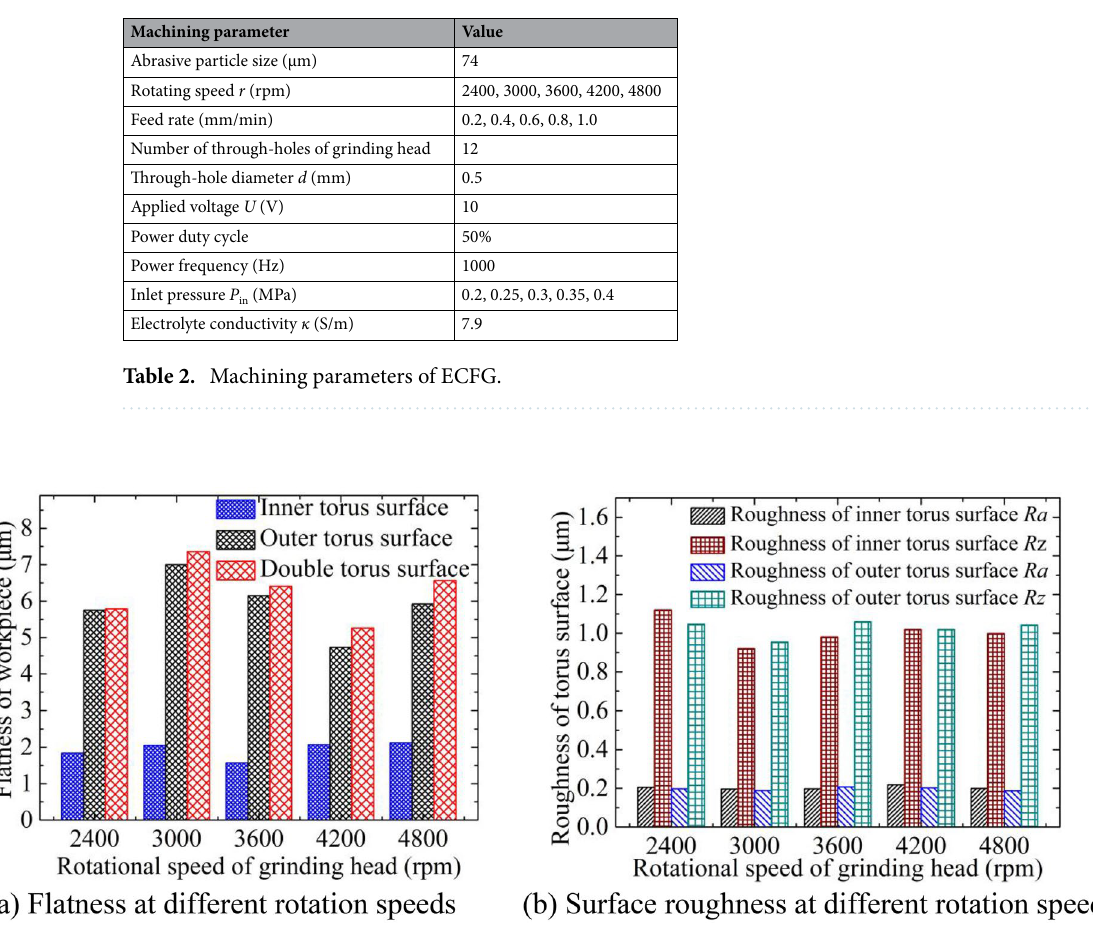
Figure 6. Flatness and roughness at different rotation